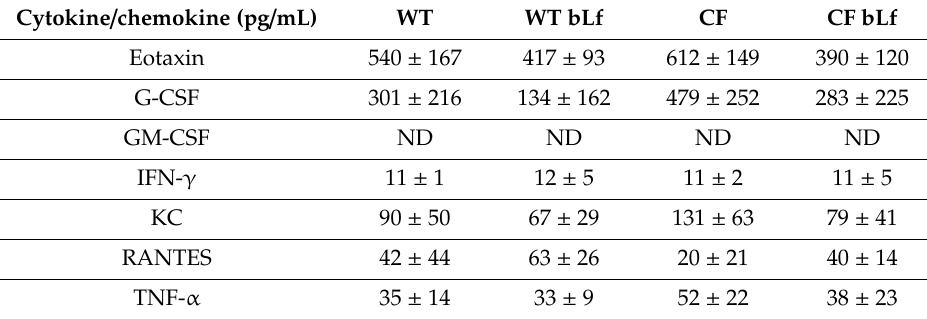
Figure 5. Changes in ferroportin ( A ), ferritin ( B ), transferrin receptor ( C ) levels in lung homogenates analyzed by Western blot and total iron content ( D ) in BALFs of WT and CF mice after 7 treatments with aerosol administration of 50 μ L sterile saline or 200 μ g/50 μ L bLf. ( E ) Representative Western